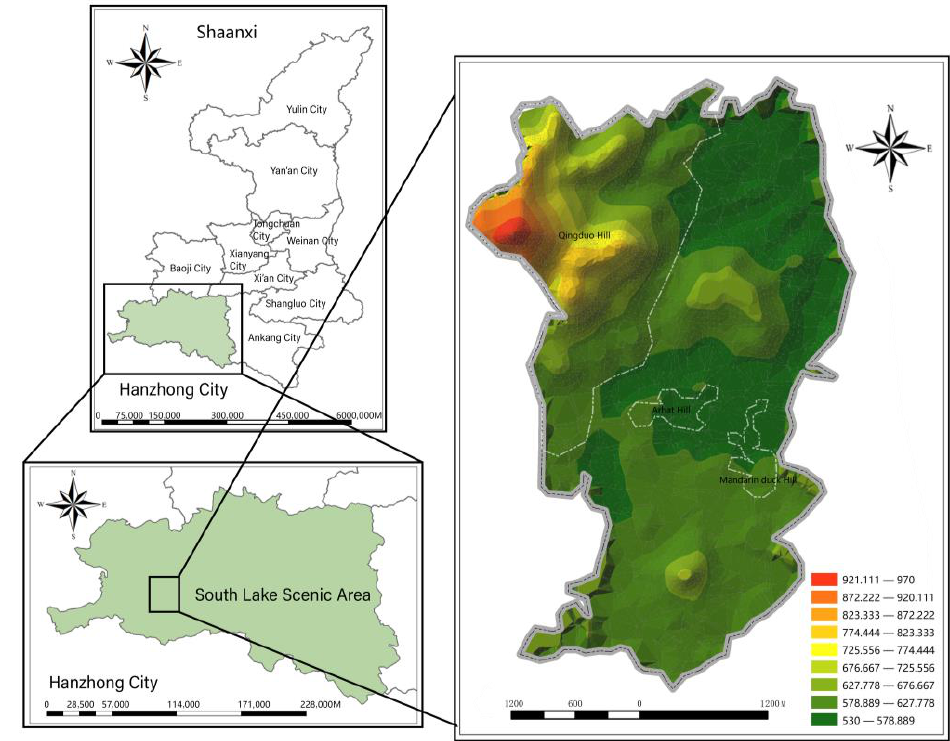
Figure 1. Geographical location of the study area .